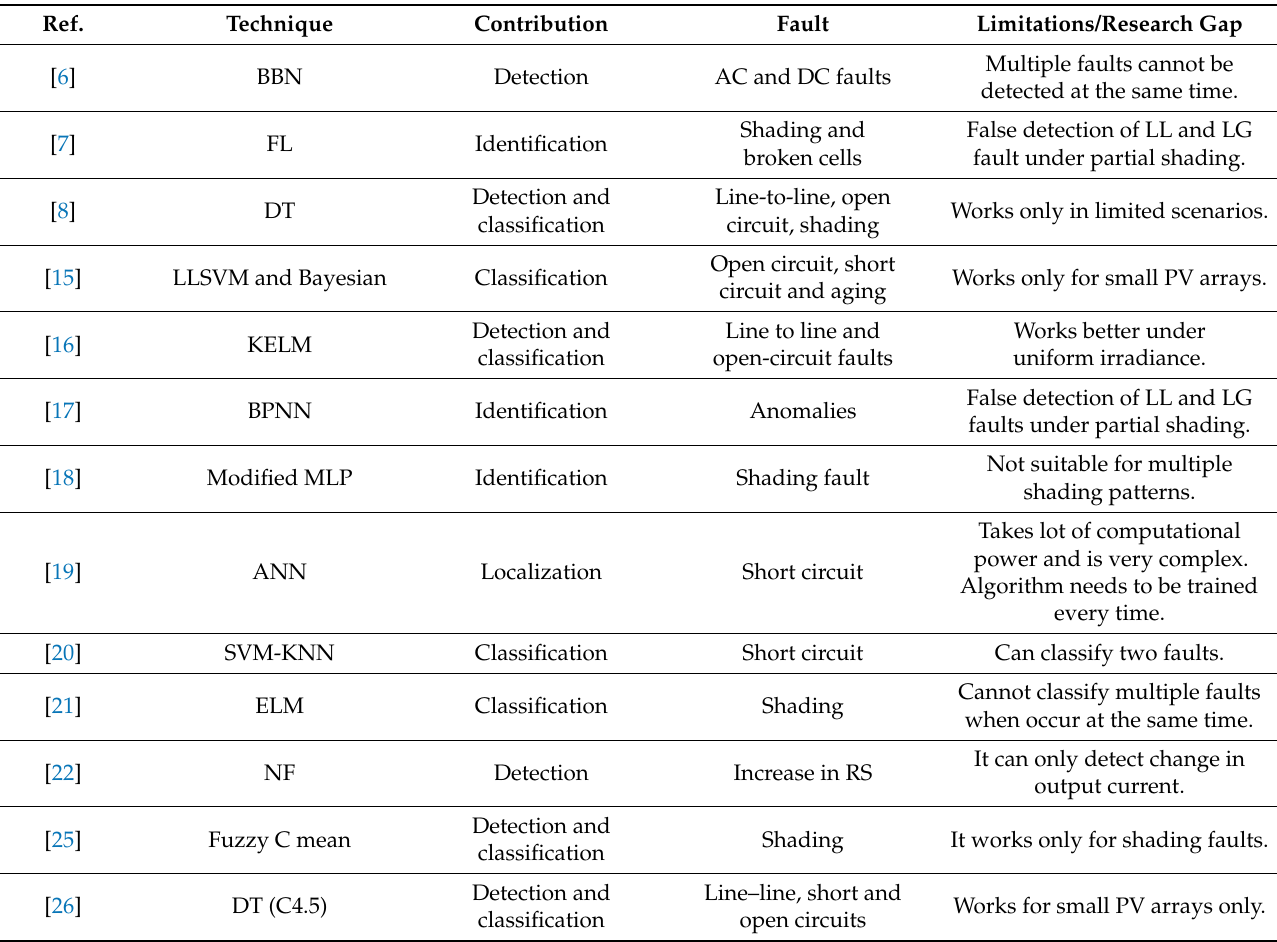
Table 1. Applications of ML for PV